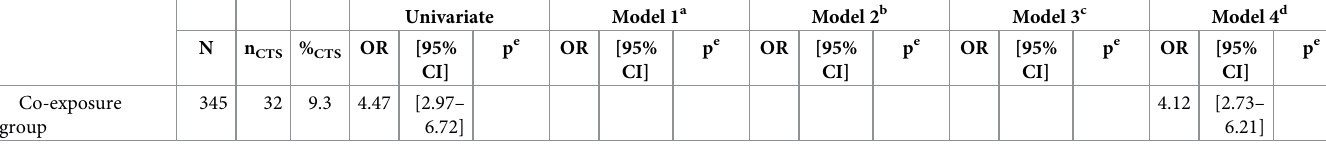
Model 1: Including personal and medical risk factors. b Model 2: Biomechanical wrist exposure added to model 1. c Model 3: Chemical exposure added to model 1. d Model 4: Exposure to Biomechanical wrist stressors and chemical exposure including a co-exposure group added to model 1. e In bold, p <